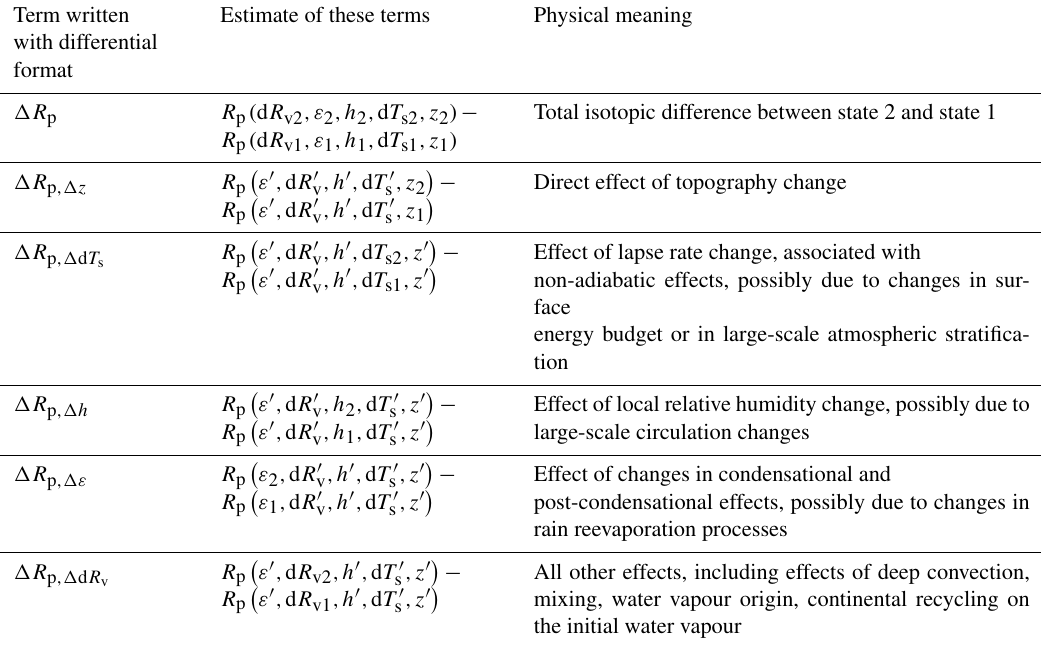
Table 1. Table detailing how the different terms of the decomposition for (cid:49)R p , as written in Eq. (7), are estimated. Estimate of these terms Physical Term written with differential format